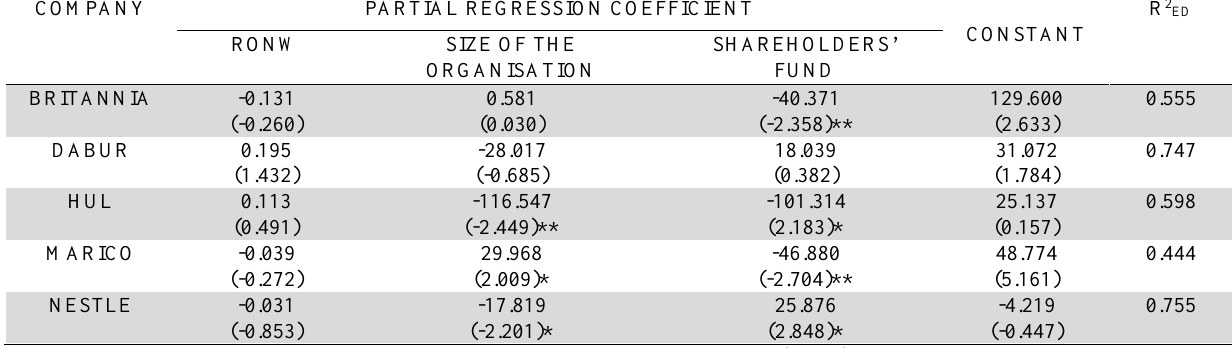
Analysis of Multiple Regression of CCC on RONW, Size of Org. and shareholders’ Fund of the Selected Companies of FMCG Sector. Regression Equation is CCC = a 0 +a 1 RONW+a 2 Size of Org.+a 3 Shareholders’